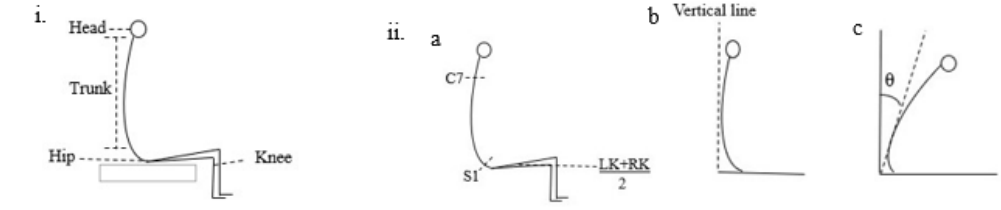
Figure 3. The principle of data analysis process of Vicon data for trunk flexion movement: ( i ) The erect sitting posture with knees in 90 degrees flexion and feet flat on the floor. For measuring flexion angle ( ii-a ) segments C7, S1, and the midline connecting the left knee (LK) and right knee (RK), ( ii-b ) an axis connecting the C7, S1 segments with a perpendicular line through the middle of the knees, ( ii-c ) flexion movement was performed, and angle measured in degrees ( θ ). The partici- pant was allowed to take the required time to successfully and independently complete the move- ment. Similarly, measurements for other movements are presented in the Supplementary Materials (Supplementary Figure